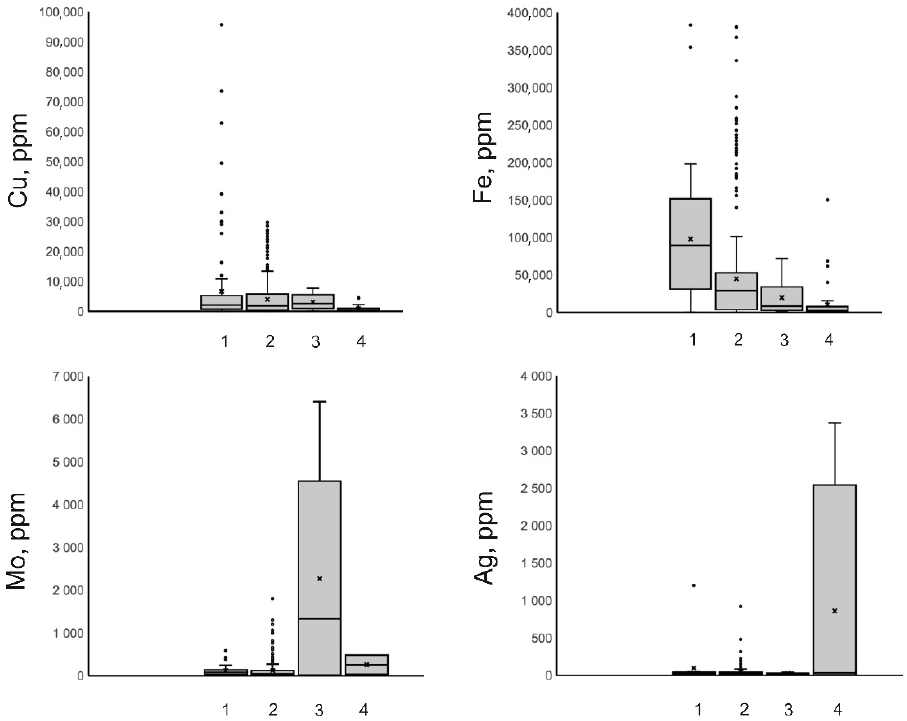
Figure 10. Boxplots for concentrations of Cu, Fe, Mo, and Ag, in mineralizing fluids at porphyry deposits of various types (1–Cu (Au); 2–Cu, Mo (Au); 3–Mo; 4–Au).